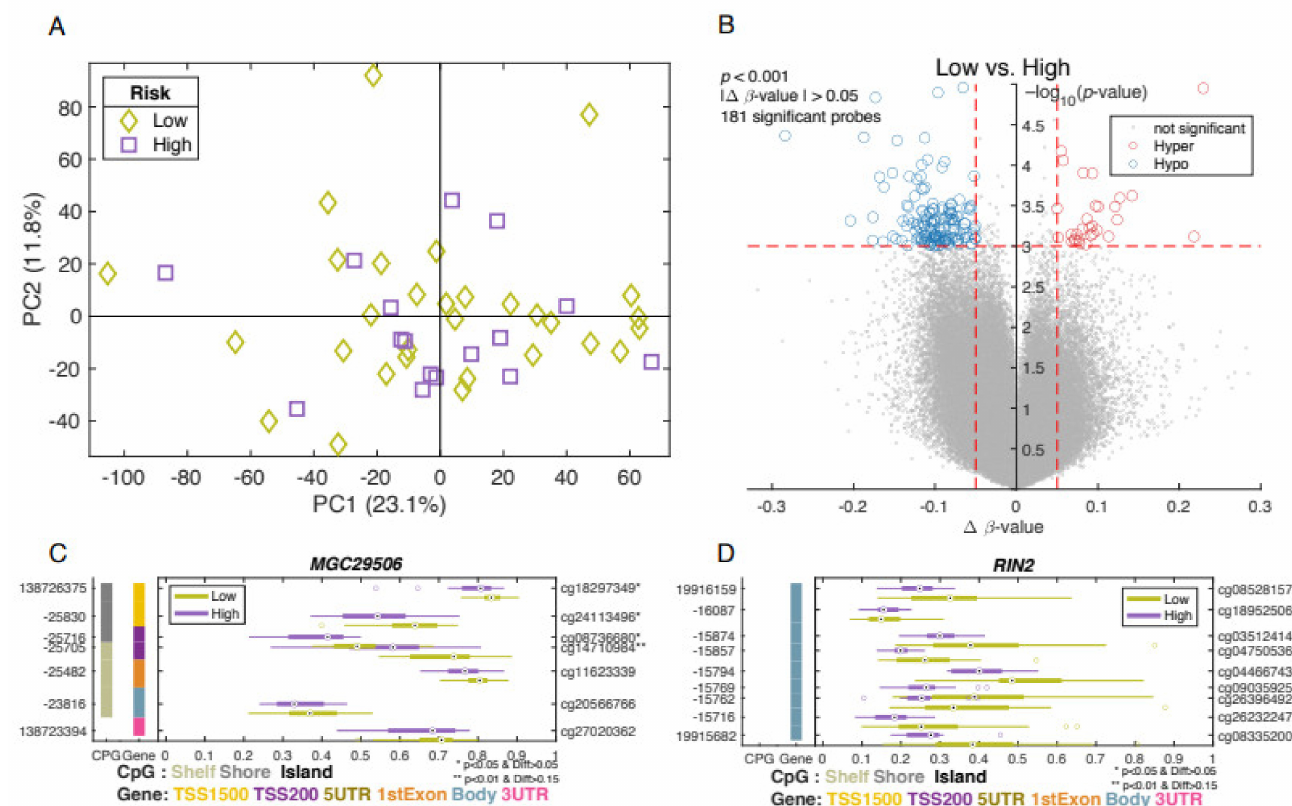
Figure 3. Analysis of high-risk vs. low risk. The two first principal components in a PCA model using all tumor samples ( n = 49) and all CpG-probes ( n = 785,071) with low-risk tumors (green diamonds) and high-risk tumors (purple squares) ( A ). A volcano plot comparing low-risk tumors vs. high-risk tumors with ∆ β -value on the x -axis and p -value, − log 10 ( p -value), on the y -axis ( B ). Blue circles indicate significant hypo-methylates CpG-probes and red circles hyper-methylated CpG-probes. GSM plots comparing the methylation levels between low-risk tumors and high-risk tumors for MGC29506 ( C ), RIN2 ( D